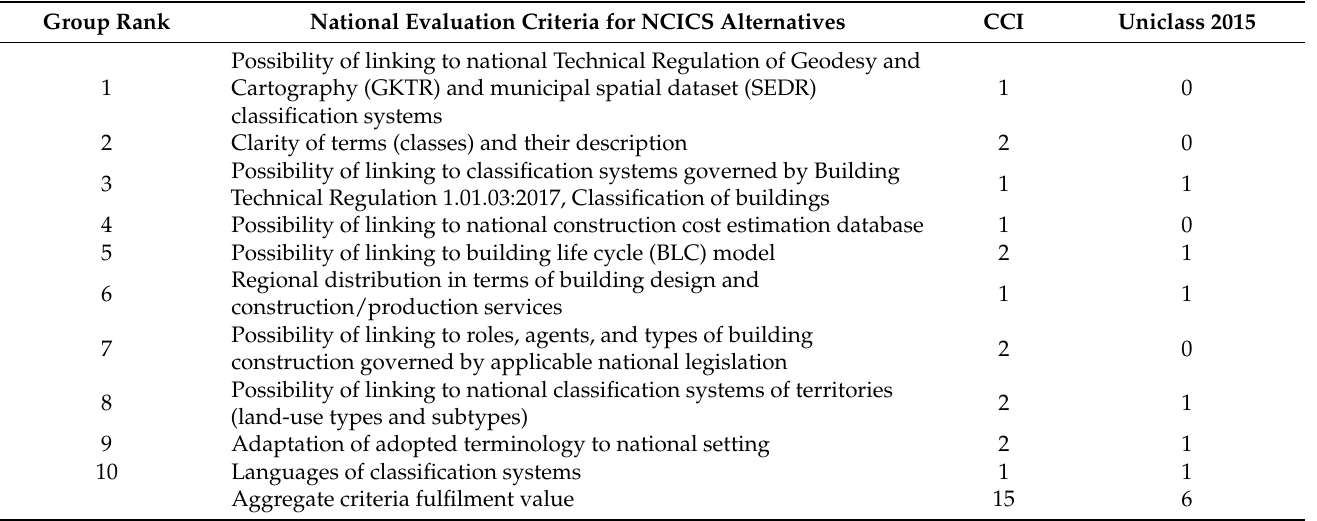
Table 6. Ranking of criteria groups and values of Kendall’s concordance coefficient.